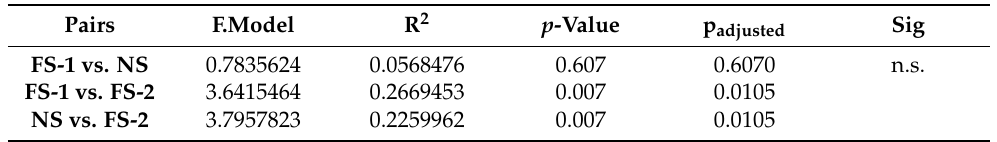
Table 1. Result of pairwise multilevel comparison of contemporary Cladoceran assemblages in the three sites of the oxbow lake using